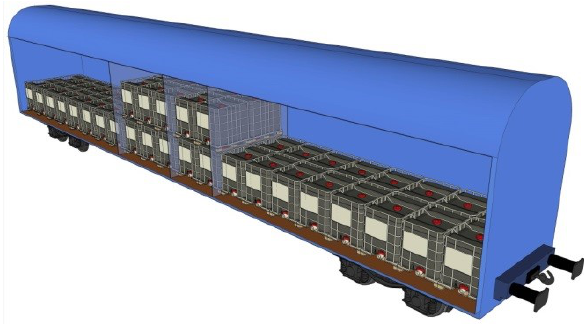
Figure 7: Proposal for load distribution of 52 IBC containers in the case of the railway wagon Habbillns with payload of 59 t [3]